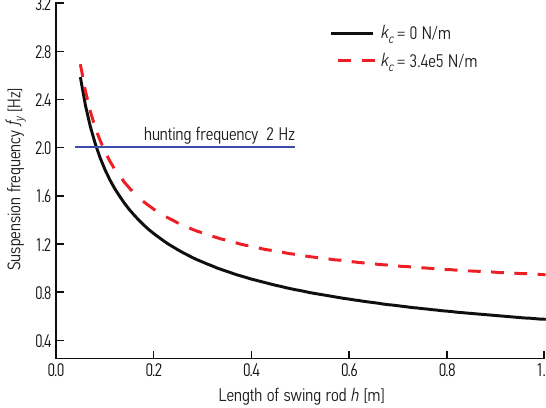
Fig. 18. The suspension frequency of drive system A